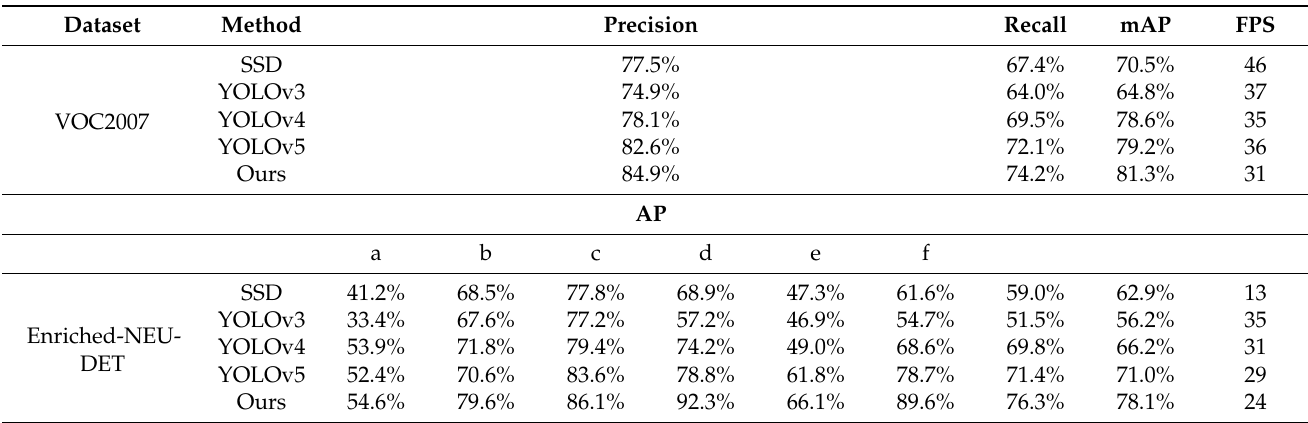
Table 4. The comparison results with related